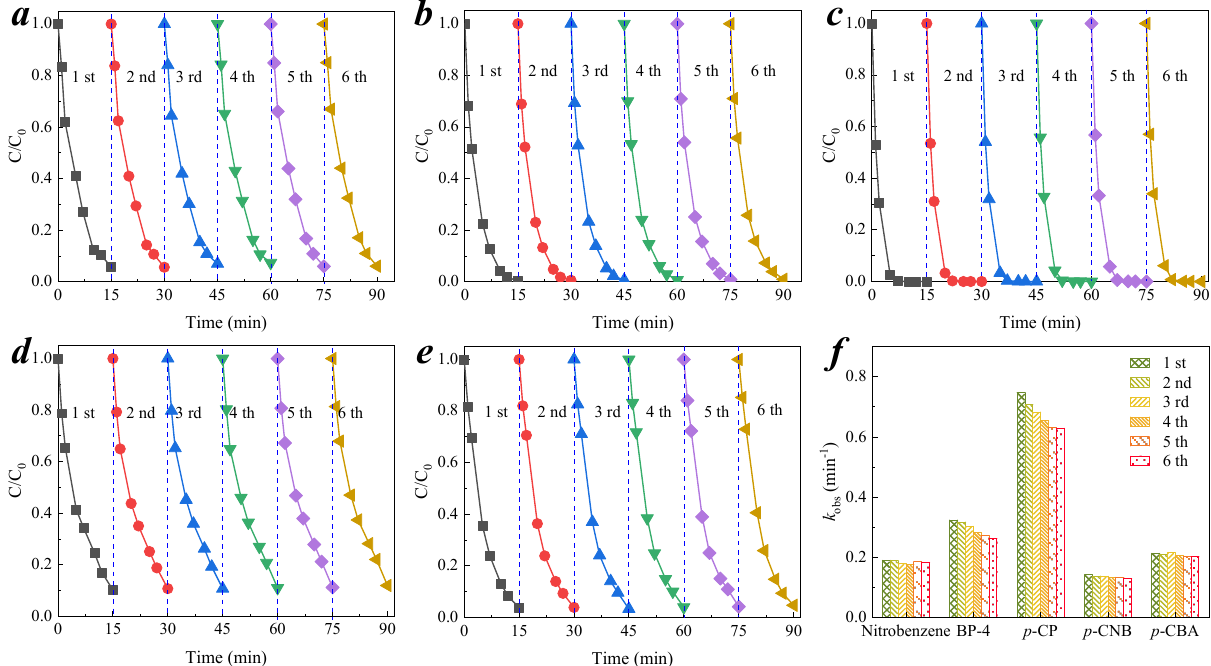
Figure 8. Reuse of the CM–ozone catalyst process in the degradation of organic pollutants. Degradation of ( a ) nitrobenzene;